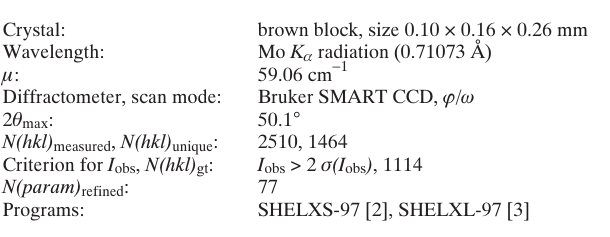
Table 1. Data collection and handling.